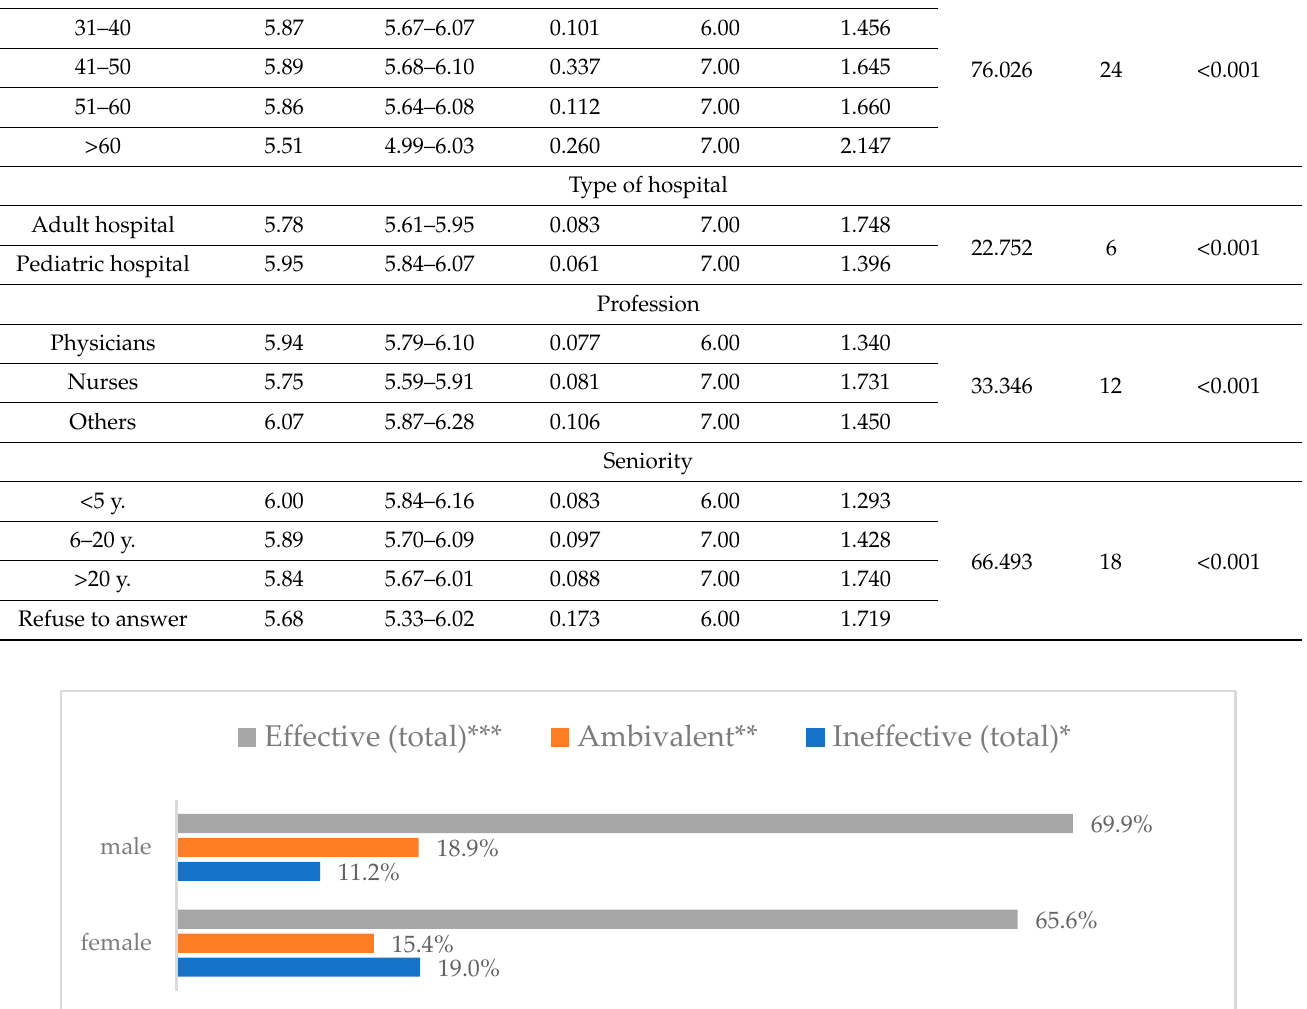
Figure 6. Hand washing to prevent influenza virus infection by gender ( N = 905). *Sum of responses: completely ineffective, ineffective, rather ineffective; **Response: neither ineffective nor effective; ***Sum of responses: rather effective, effective, completely effective.